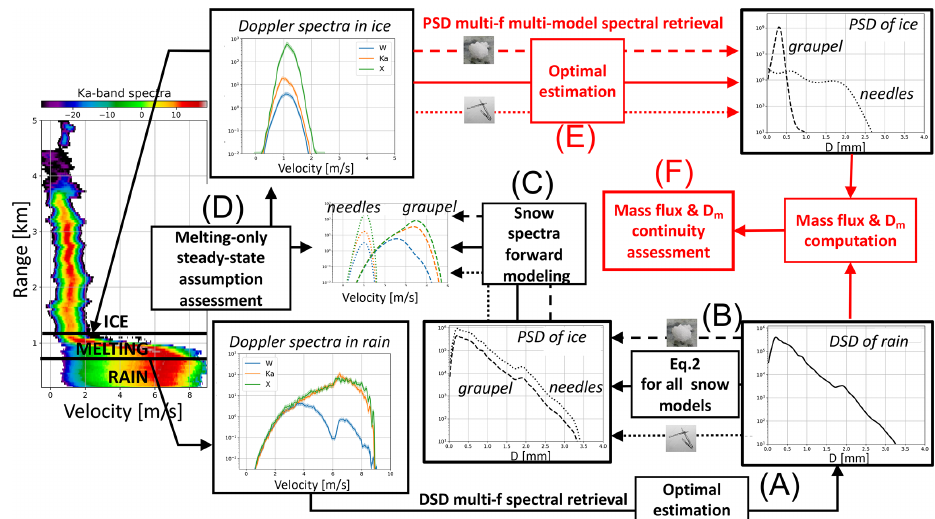
Figure 2. Schematic illustrating the rationale of the spectra closure study: by linking microphysical properties of rain just below the melting layer and of ice just above, the MOSS (black arrows) and the mass flux continuity (red arrows) assumptions can be evaluated.